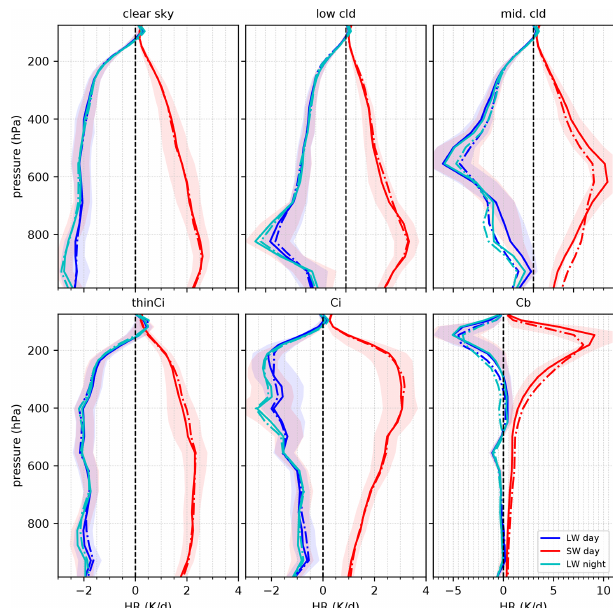
Figure 3. Predicted LW heating rates and SW heating rates (full line), separately for clear sky, low- and mid-level clouds, thin cirrus, Ci and Cb, as identified by AIRS-CIRS, averaged over the AIRS swaths within 30 ◦ N–30 ◦ S, in January 2008. 30% and 70% quan- tiles of the distributions indicate their variability. The model has been trained individually over Cb, Ci/thin Ci and mid- and low-level clouds, separately over ocean and land. Broken lines correspond to the average of FLXHR heating rates averaged along the CALIPSO– CloudSat nadir tracks. Night corresponds to 01:30LT and day to